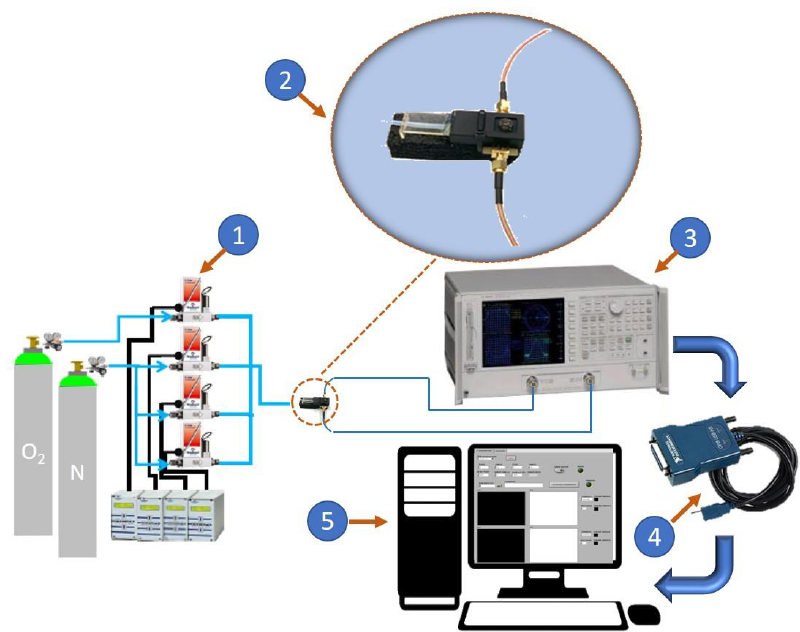
Figure 4. Illustration of the experimental set-up. It consists of five main blocks: (1) the controlled gas system, (2) the measurement chamber, (3) the vector network analyzer, (4) the USB/GPIB interface, and (5) the graphical user interface.